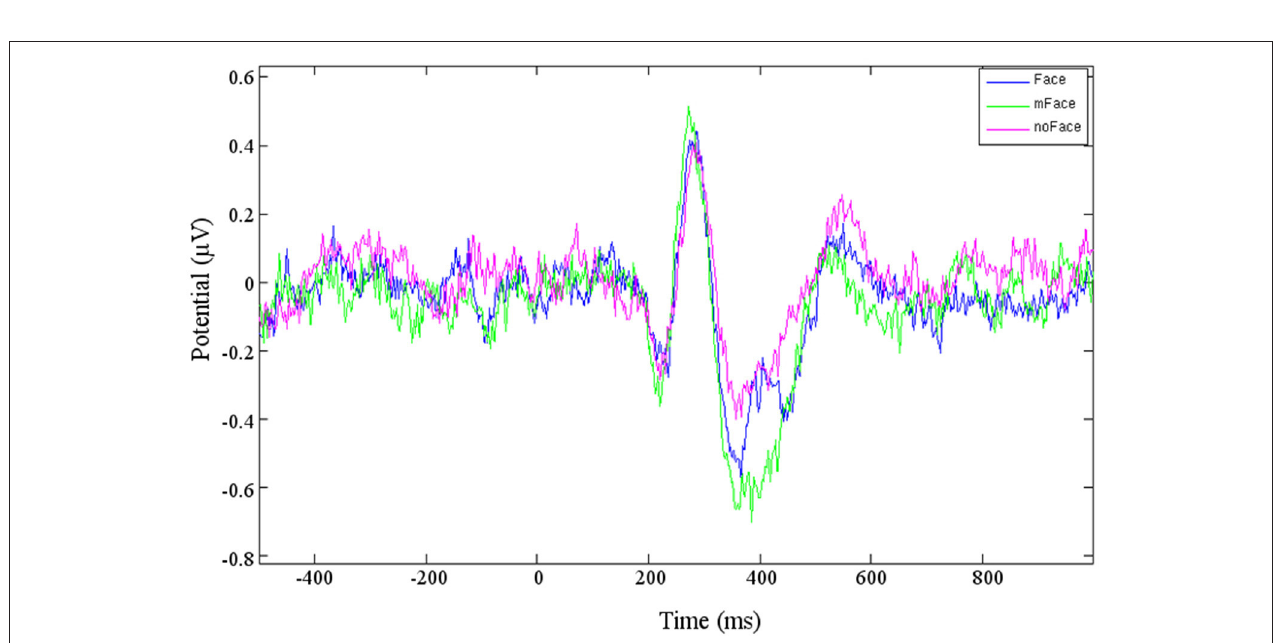
FIGURE 3 | Averaged ERP of the three conditions of cluster 4.